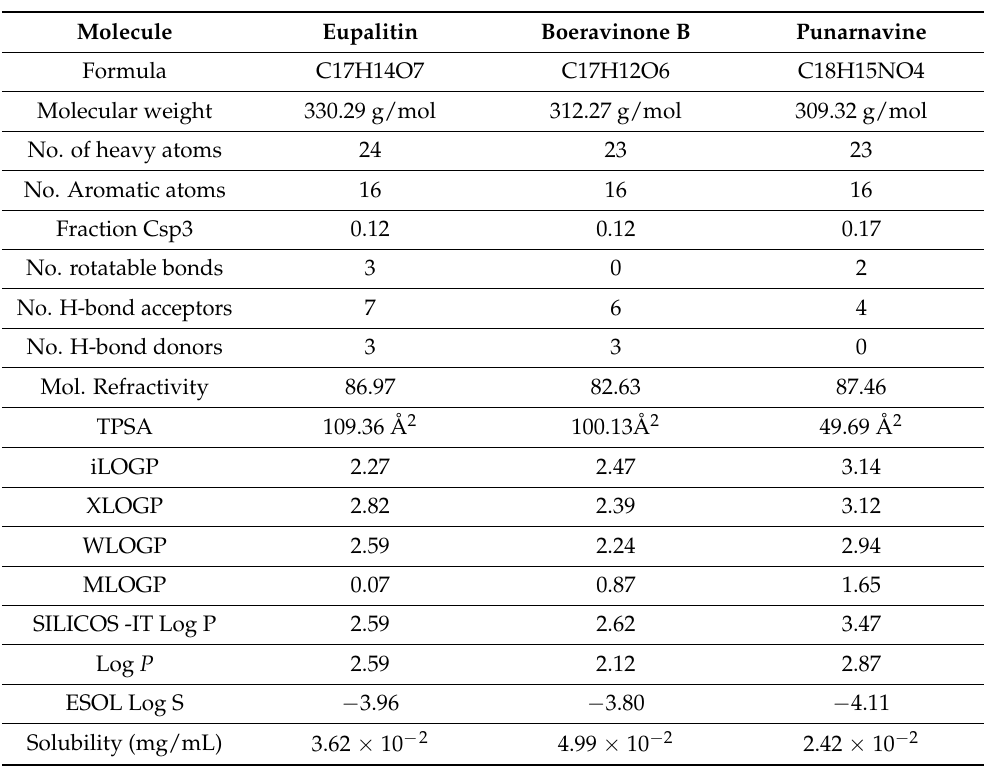
Table 2. Absorption, distribution, metabolism, excretion, and toxicity (ADMET) analyses of the selected bioactive